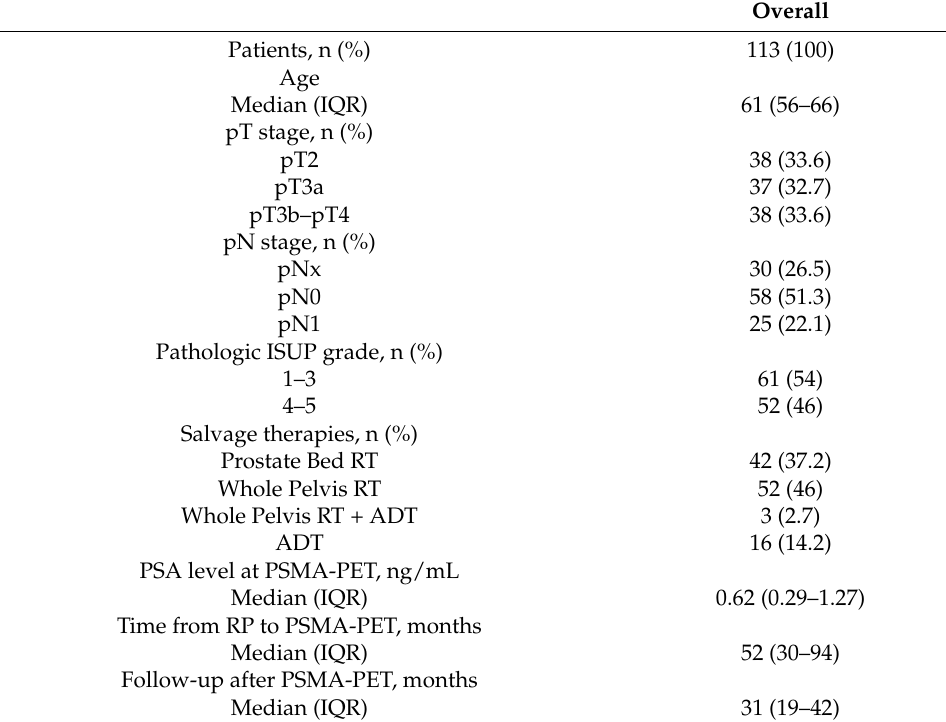
Table 1. Overall descriptive characteristics in the overall population (n = 113).